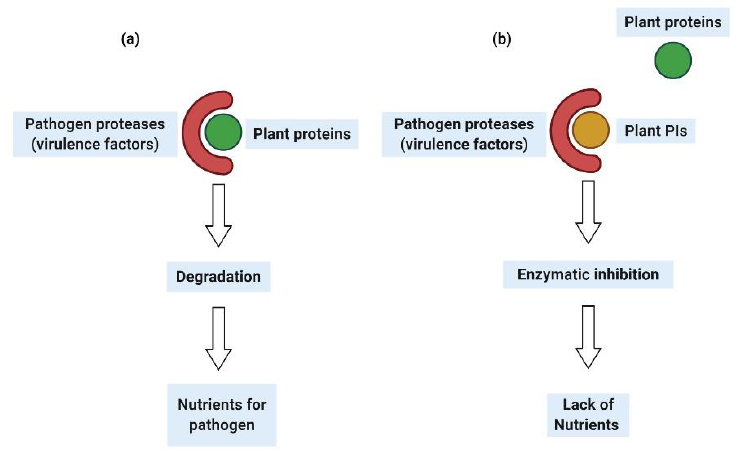
Figure 2. The action of pathogenic proteases ( a ), Action of protease inhibitors (PIs) over pathogen proteases ( b ).